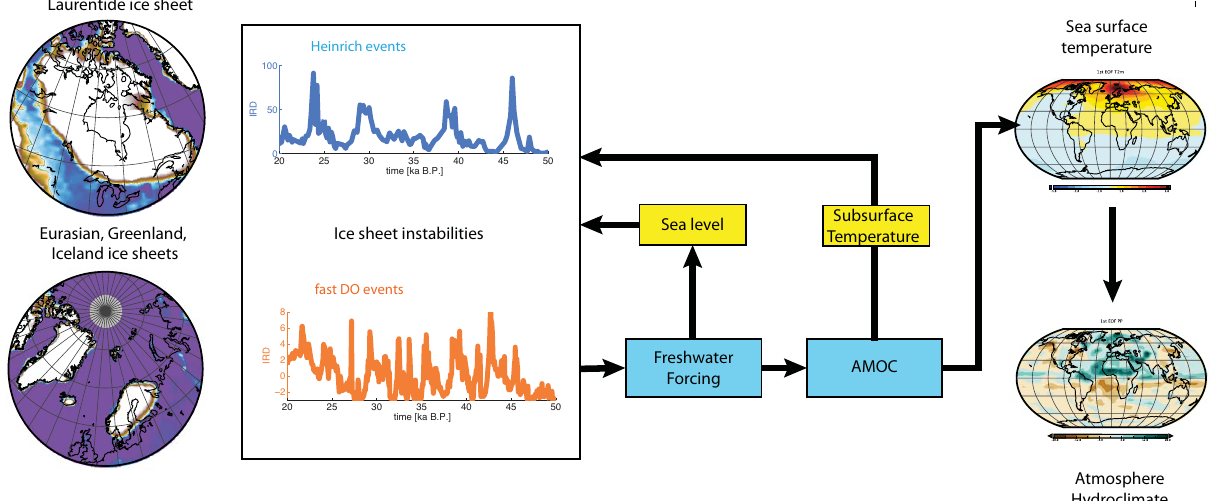
Fig. 10. Schematic illustration of the effect of northern hemispheric ice-sheet instabilities on the AMOC, SST and atmospheric circulation. AMOC changes are likely to provide a positive feedback on ice-sheet instabilities via subsurface temperature anomalies (Alvarez-Solas et al., 2010). Furthermore, sea level changes generated by one ice sheet can trigger ice-shelf instabilities in another ice sheet and subsequent accelerated flow and iceberg calving. Once the ice sheets reach a new mass balance, the freshwater input into the North Atlantic ceases and the AMOC starts its recovery thus initiating a stadial–interstadial DO